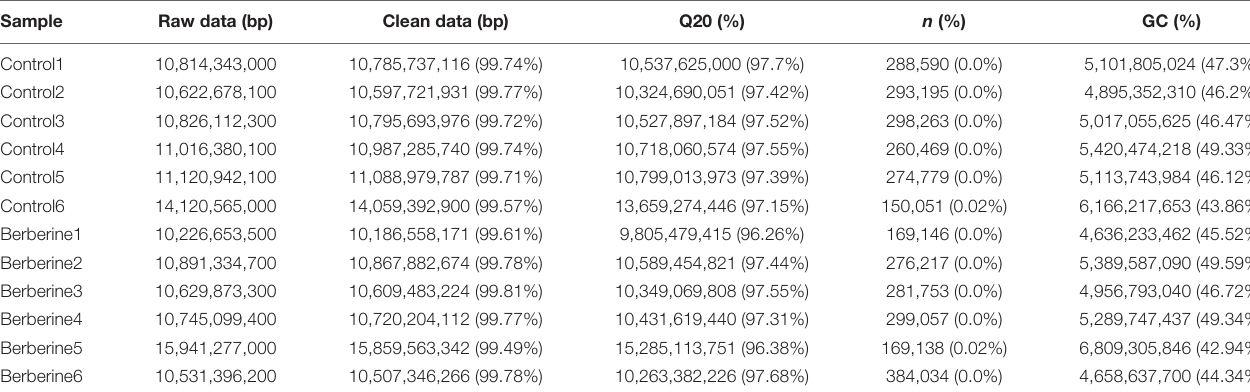
TABLE 2 | Sequencing data of intestinal microbial metagenomics in weaned piglets.